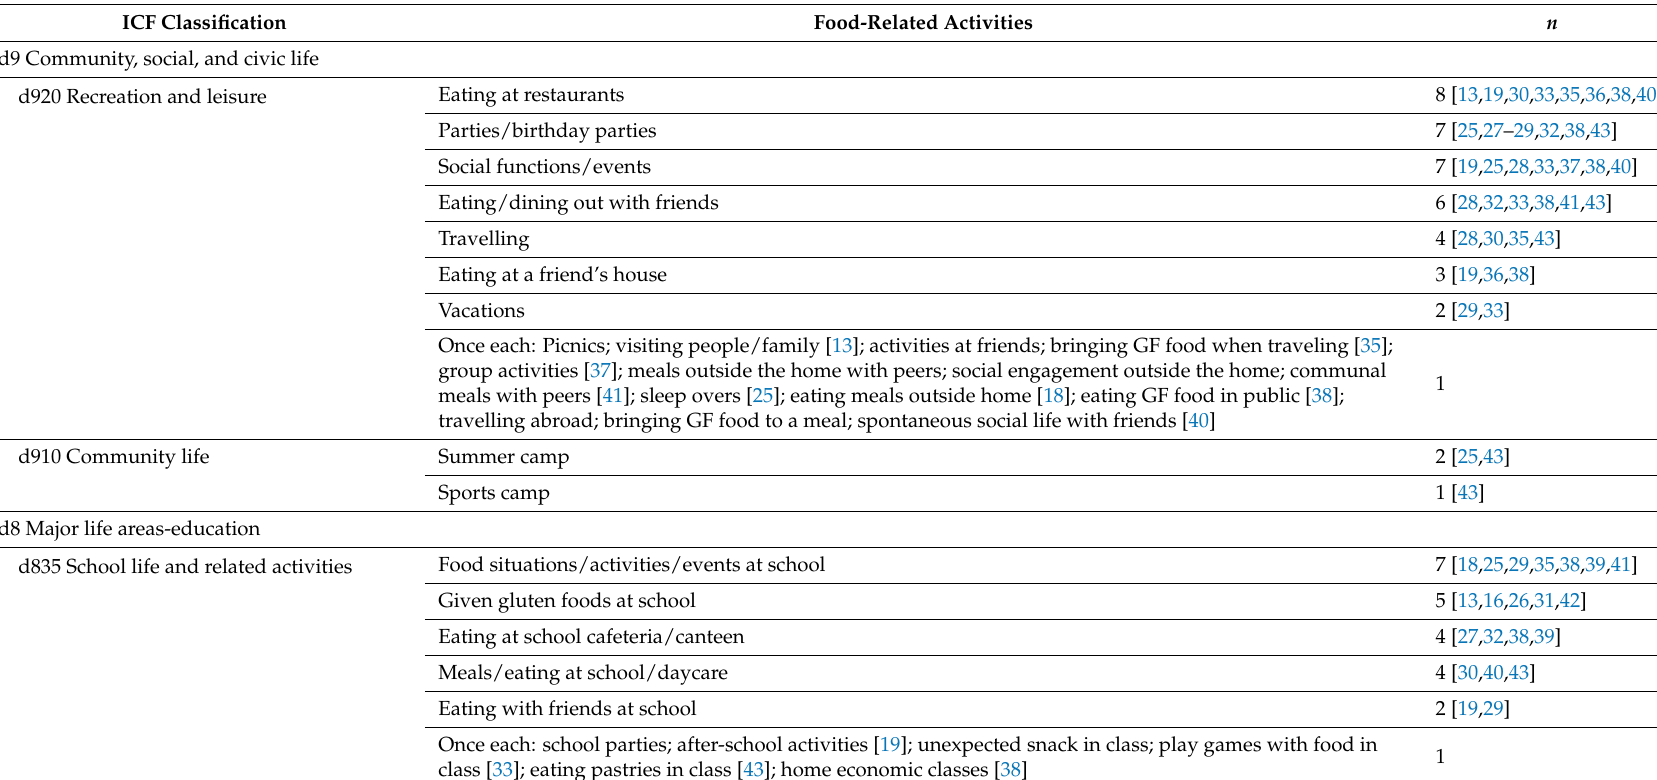
Table 2. Activities and participation first- and second-level ICF